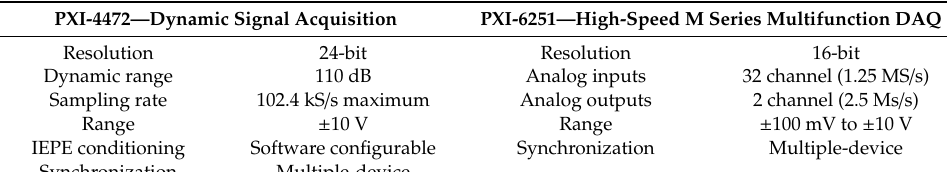
Figure 4. Performance monitoring sensors installation. Table 3. Design parameters of the data acquisition card.